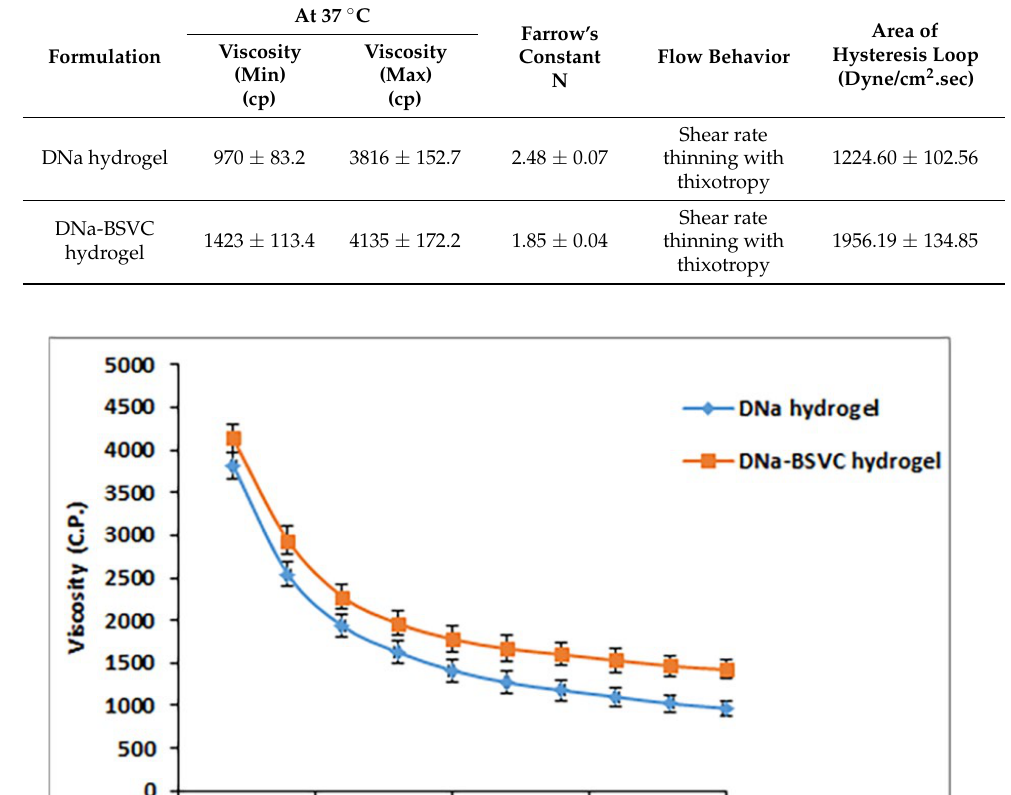
Table 5. Rheological parameters of the prepared DNa hydrogel and DNa-BSVC hydrogel.